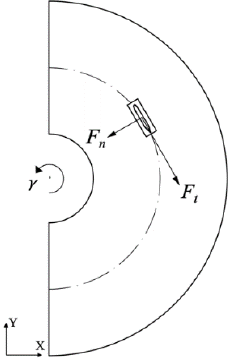
Figure 13. Schematic of the force components.